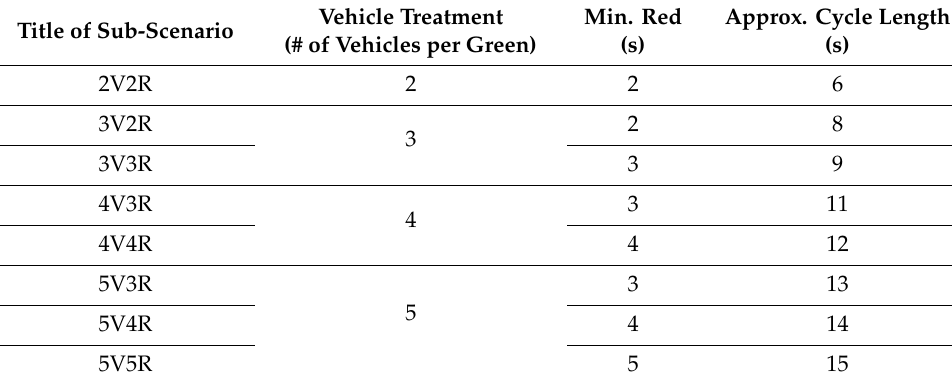
Table 3. Preparation of the sub-scenarios for the fixed time RM.